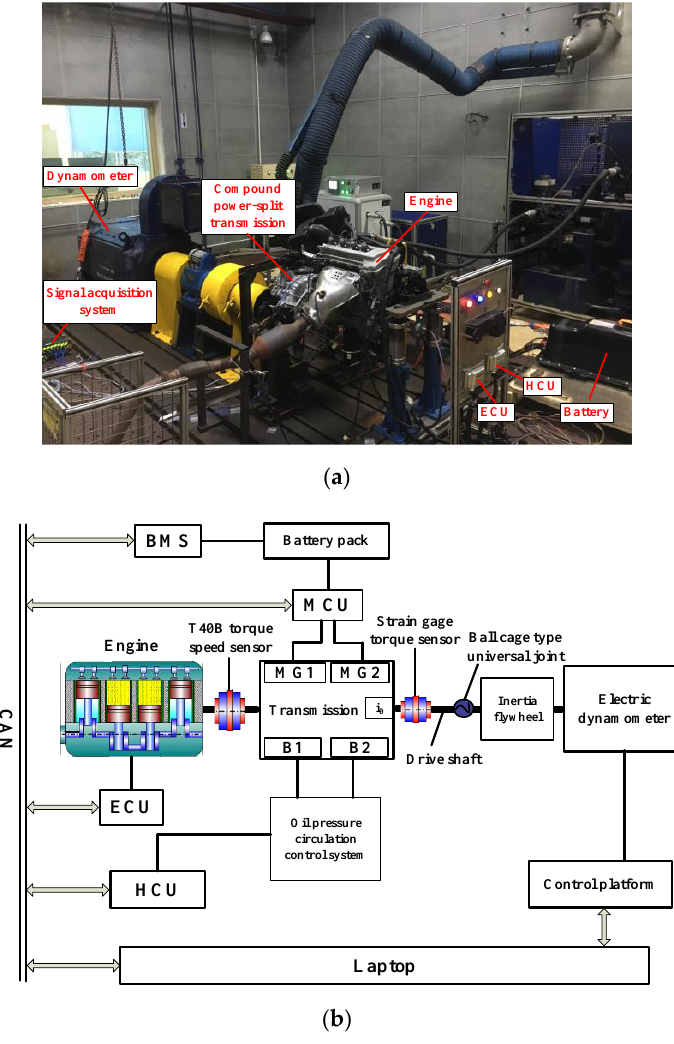
Figure 3. ( a ) Test bench for the compound PSHEV. ( b ) Layout of test bench for the compound PSHEV. Table 2. Test equipment and